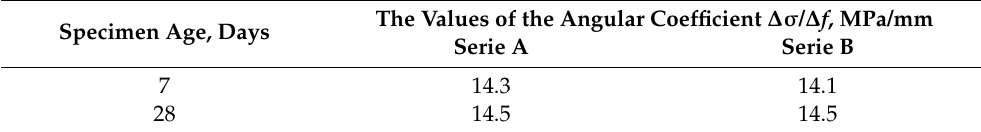
Table 3. Averaged over series and age values of the slope ∆ σ / ∆ f .